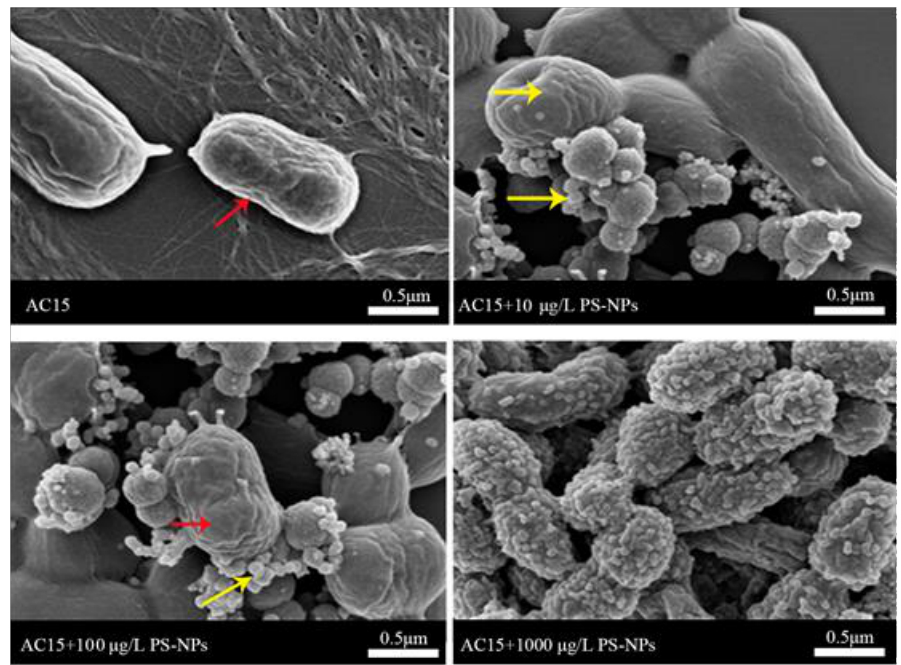
Figure 2. Scanning electron microscopy (SEM) images showing the aggregation of nanopolystyrene particle (NP) particles at concentrations of 10–1000 µ g/L on surface of A. johnsonii AC15. Red arrowheads indicate A. johnsonii AC15. Yellow arrowheads indicate the aggregated NPs on surface of A. johnsonii AC15.